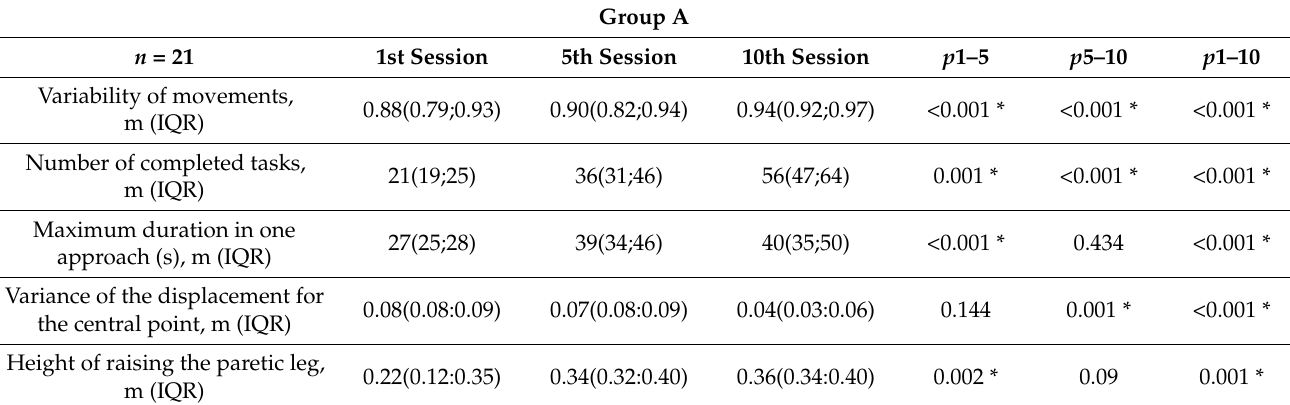
Table 5. Estimated mean differences in parameters of movement quality during AR rehabilitation in 1, 5, 10 sessions for A and B